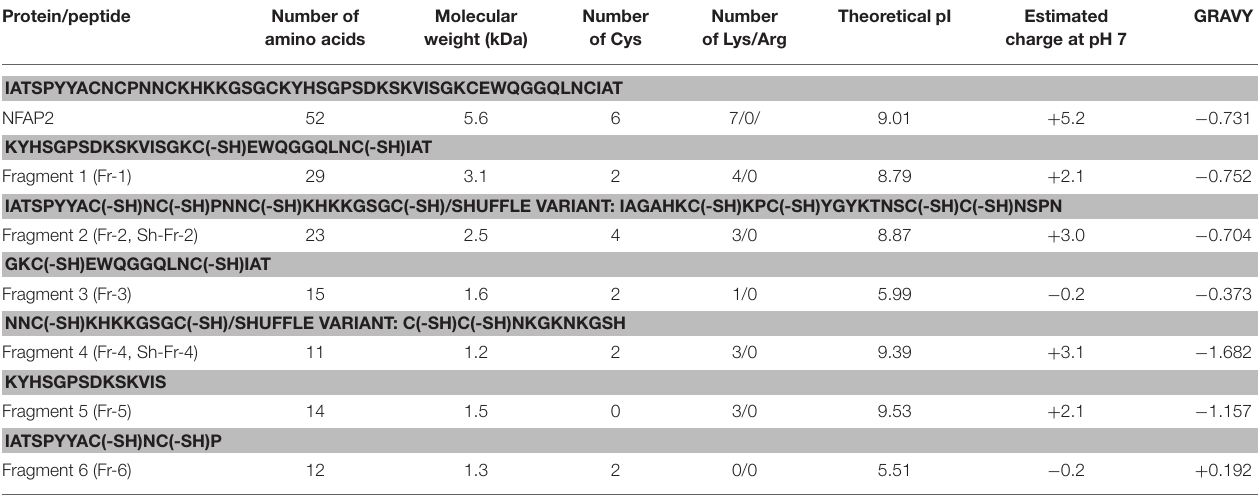
TABLE 1 | Amino acid sequence and in silico predicted physical and chemical properties of mature NFAP2 and its peptide fragments. Protein/peptide Number of